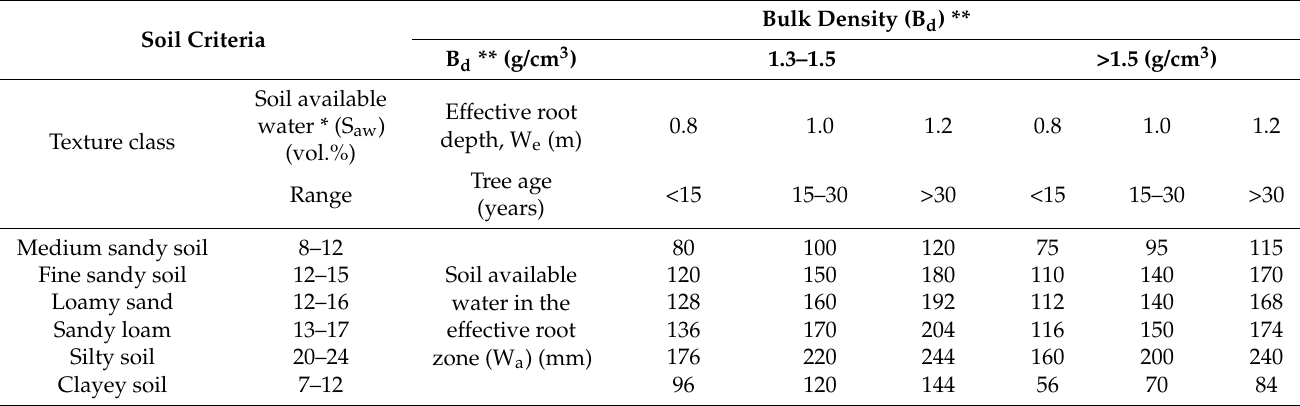
Table 5. Examples of soil available water in the effective root zone, W a (mm), for different soil texture classes and dry bulk densities (B d ) **, according to Renger et al.